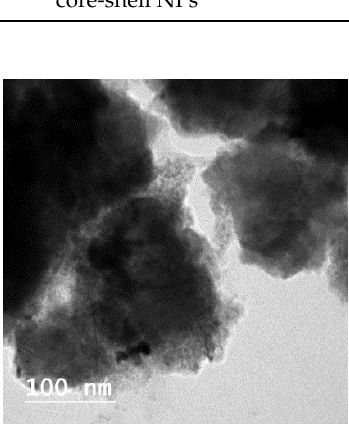
Figure 9. TEM image of magnetoliposomes containing magnetic nanoparticles decorated with